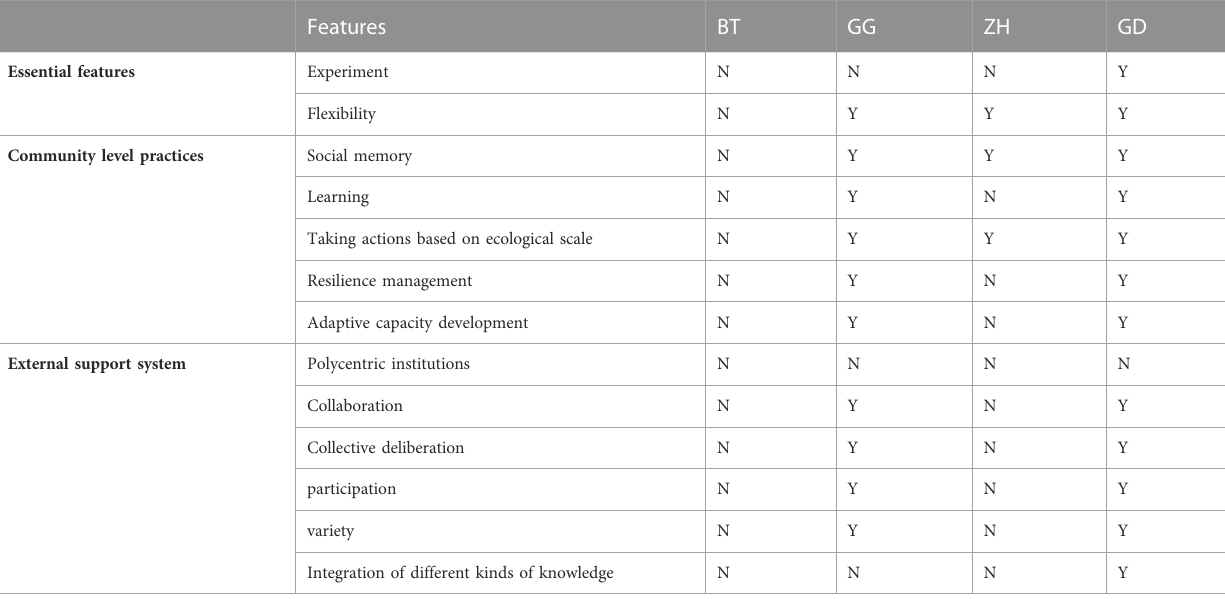
TABLE 5 Evaluation of adaptive governance implementation of four